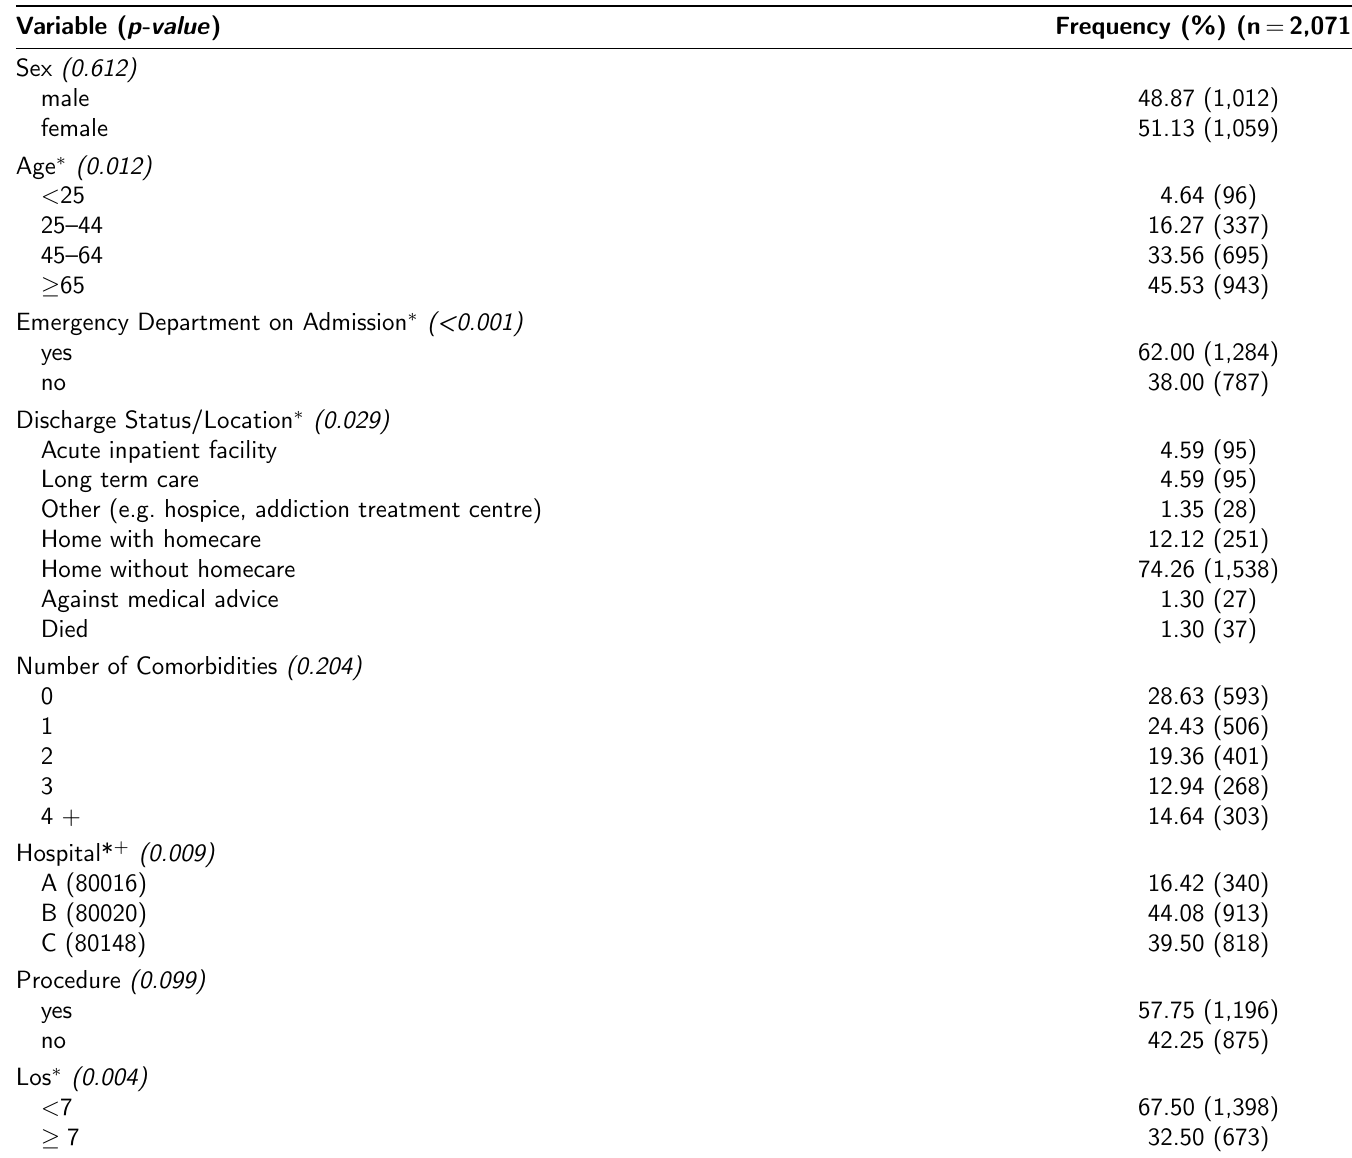
Table 3: Proportion of main condition agreements stratified by variable